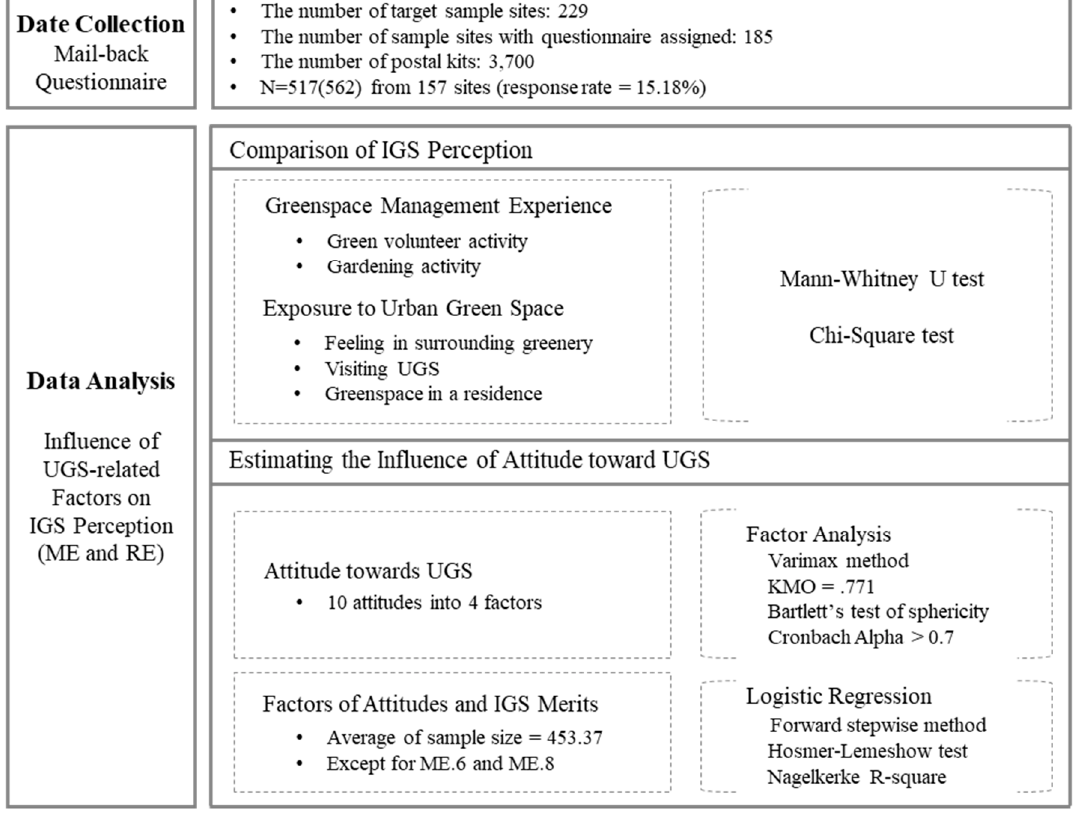
Figure 4. Research workflow.